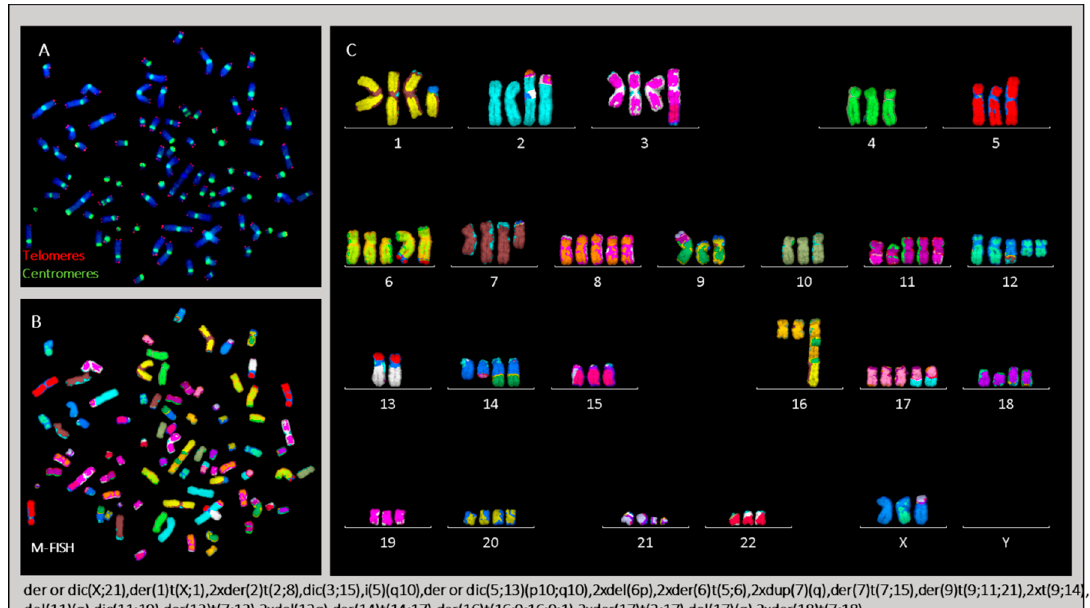
Figure 11. Chromosomal aberrations detected in L428-c cells by telomere and centromere staining ( A ) followed by M-FISH ( B , C ). Most clonal aberrations listed at the bottom of the figure are shared with those in the parental L428 cell line (63× magnification).